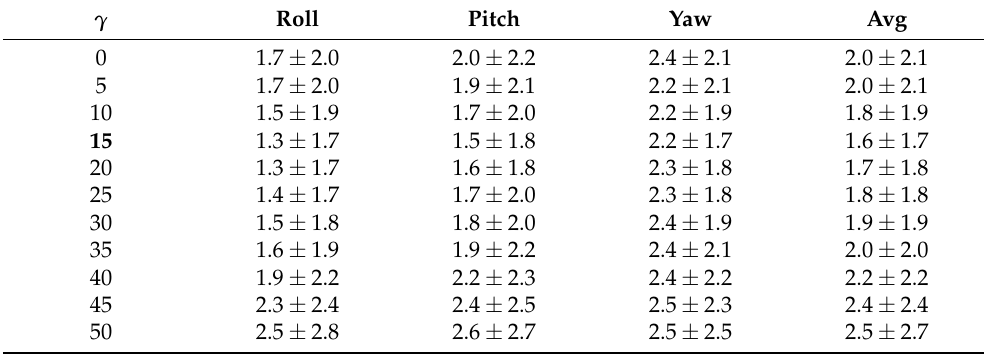
Table 2. Performance evaluation with different γ on the Biwi Kinect Head Pose